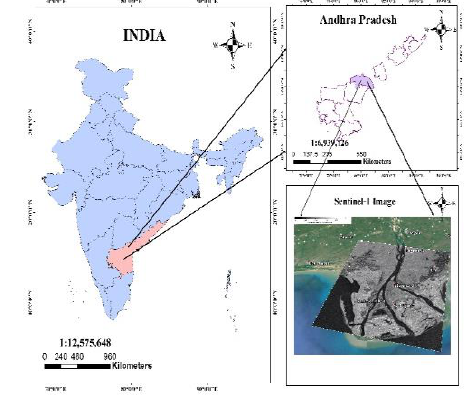
Figure 1: Map showing the Study Area- Krishna